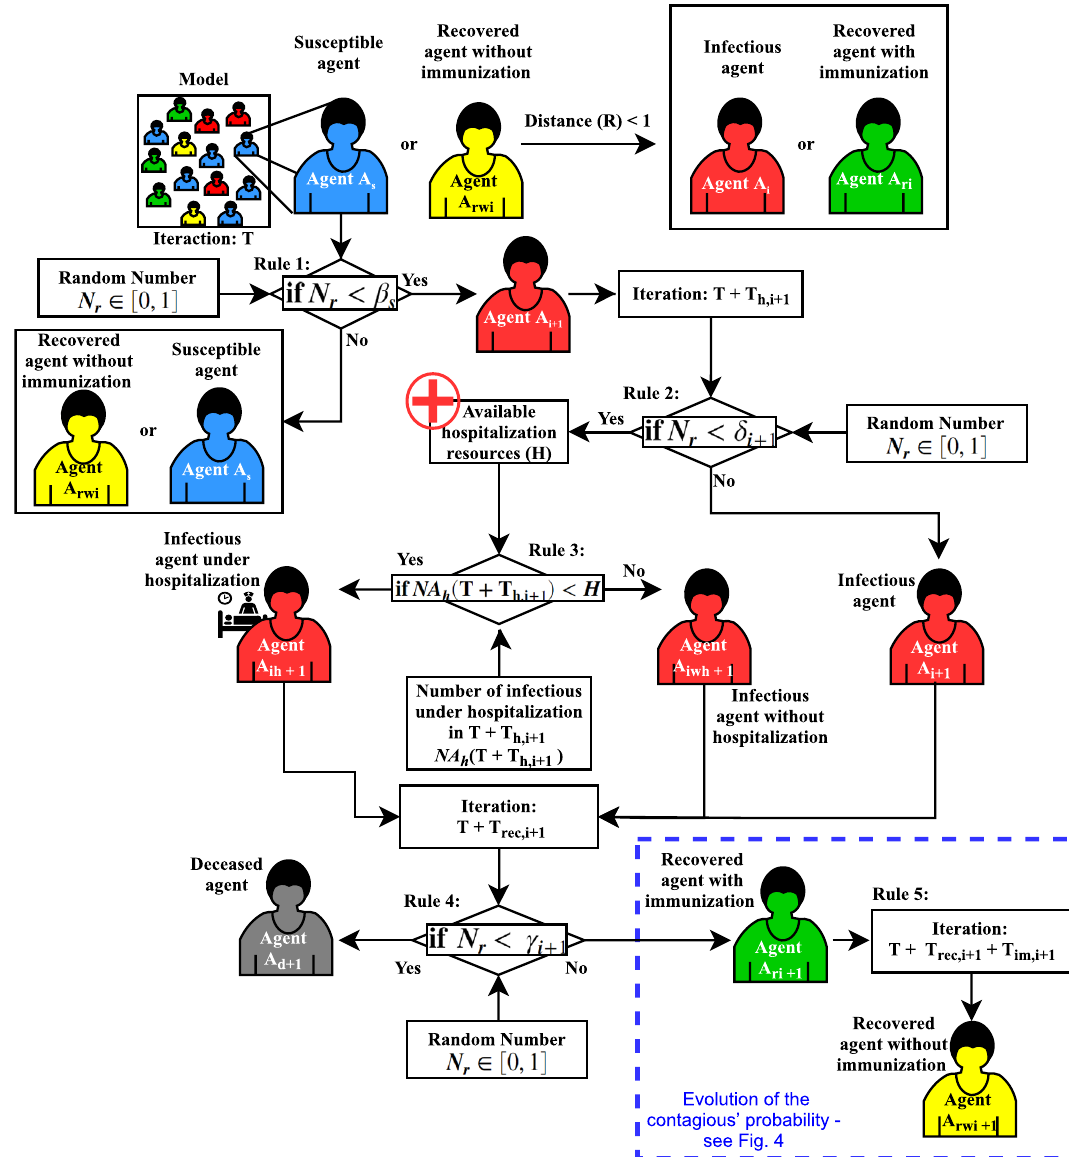
Figure 3. Roadmap of applying the agents’ infect, recover and decease evolution rules implemented in the MCovidSim-2